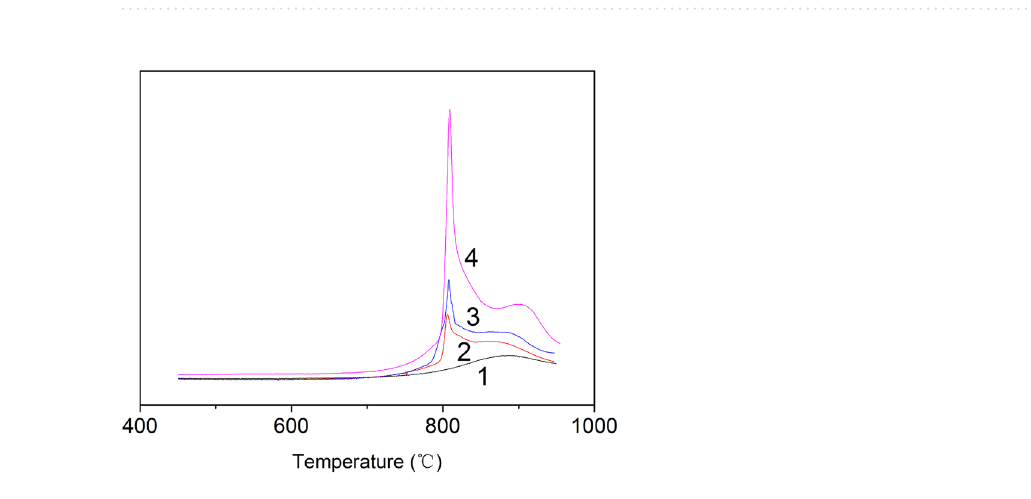
Figure 3. The variation trend of peak area ratio with the iron loadings.